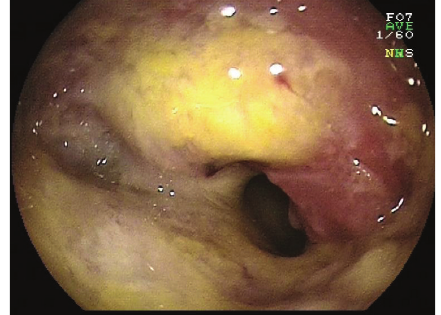
Figure 12: Stenosing adenocarcinoma of the